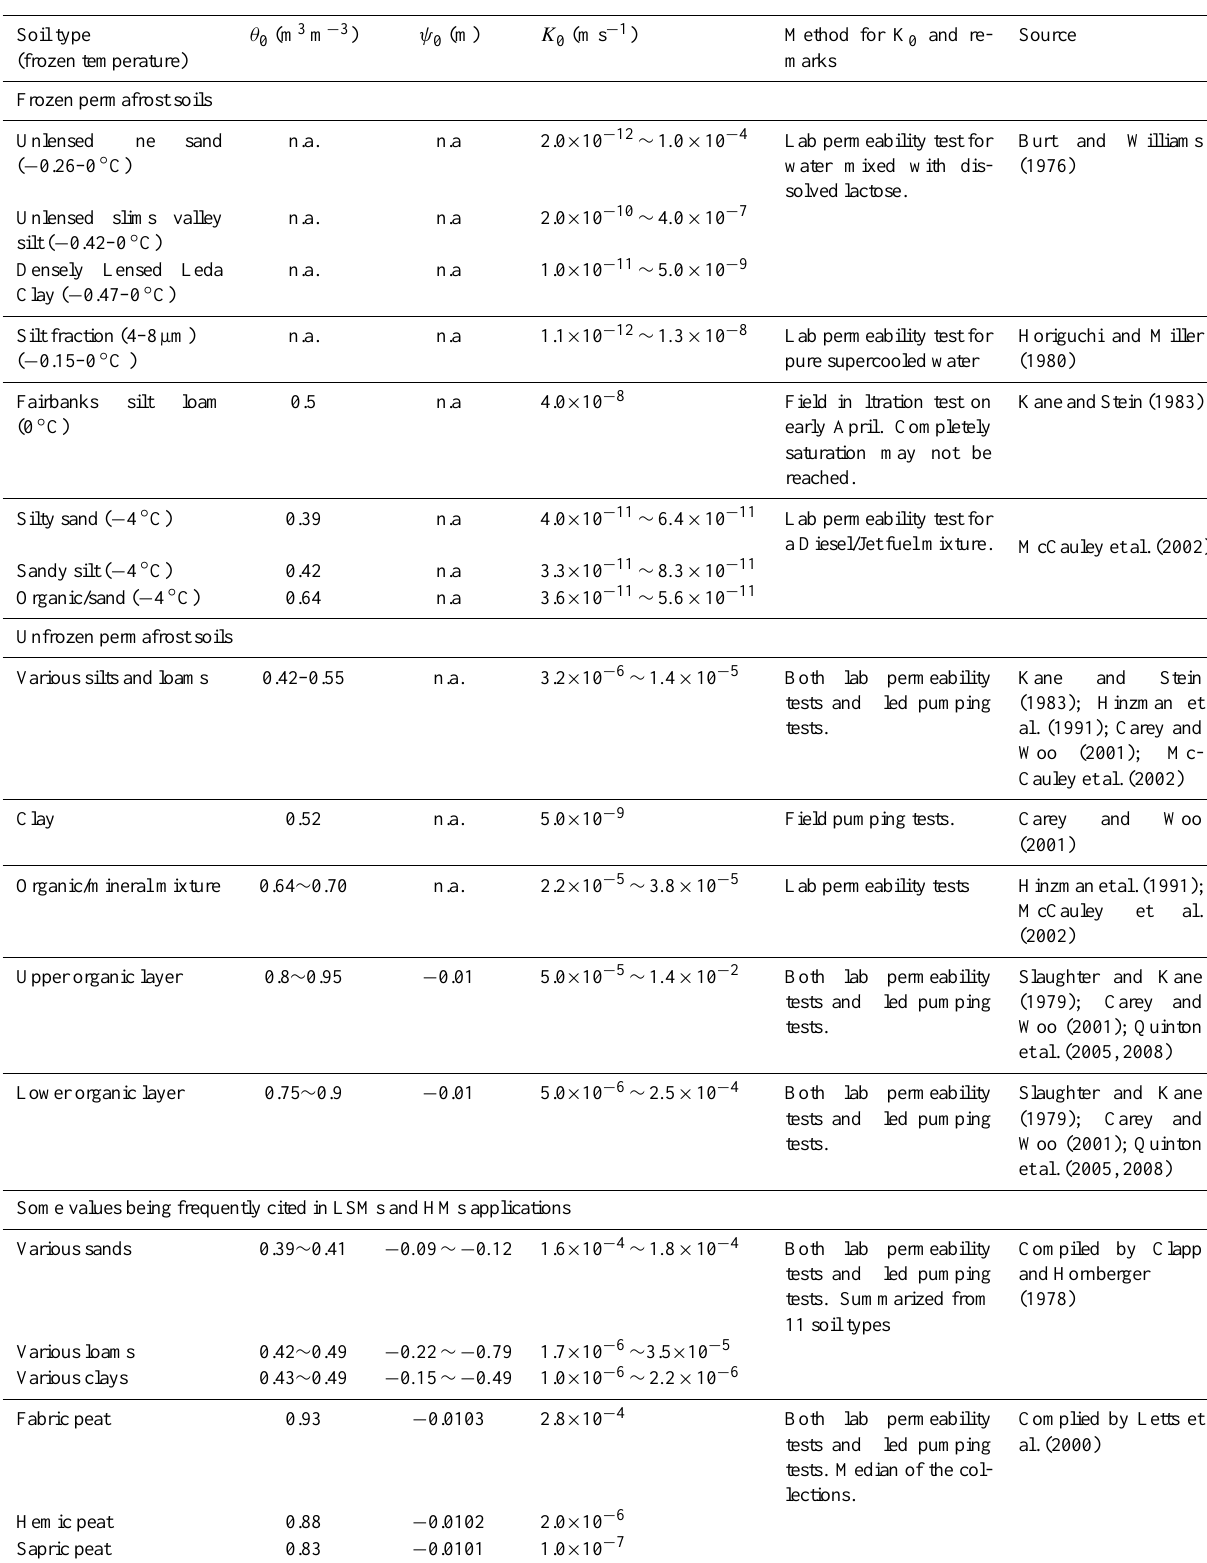
Table 3. Some reported hydrologic properties of permafrost soils and comparison with two sets of frequently cited values used in land surface and hydrological